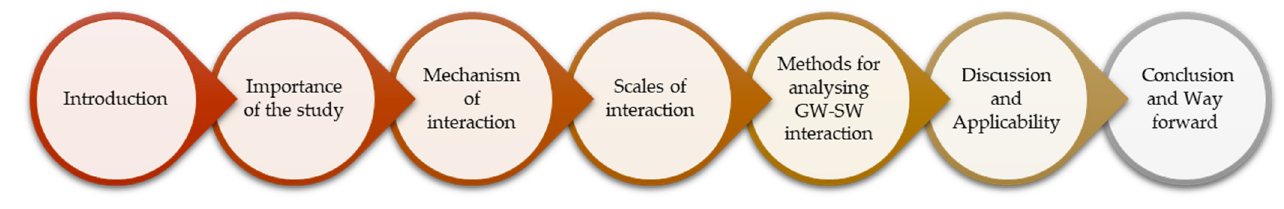
Figure 2. Layout of the